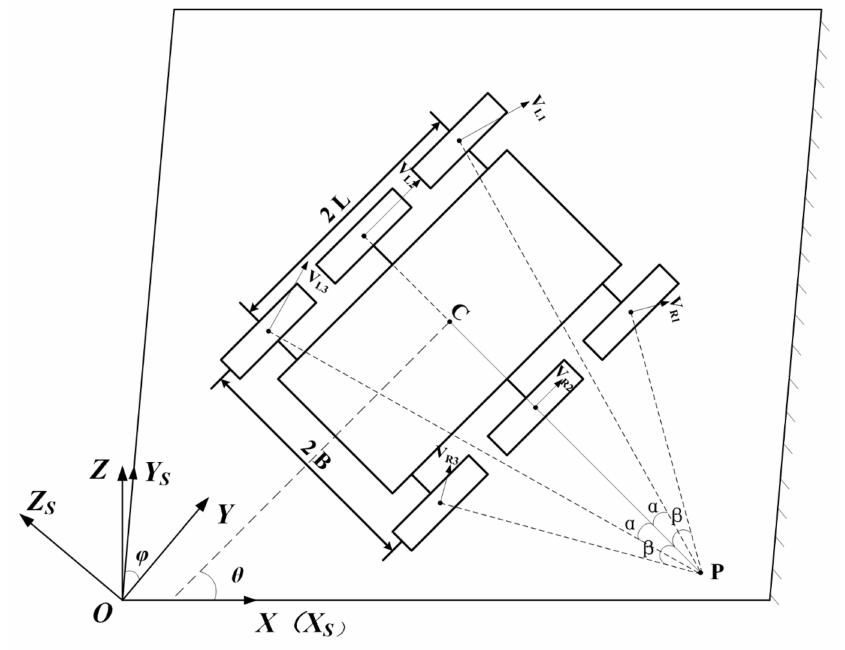
Figure 10. Schematic diagram of chassis motion model.